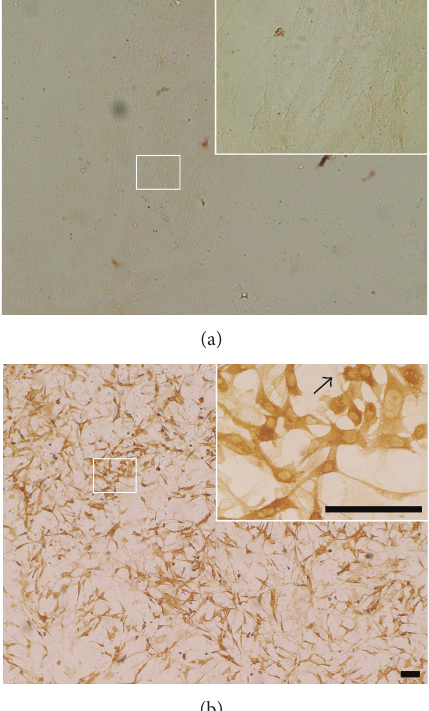
Figure 1: Immunohistochemistry of fibroblasts transfected with rAAV2-hGAD65.(a)Itdemonstratesthecontrolcellsinfectedbythe empty vector. (b) The hGAD65-positive cells were in a brown color in the cytoplasm. Fibroblasts, untransfected by rAAV2-hGAD65, were only shown in their shape (pointed by arrow). The cytoplasm expresses hGAD65, as indicated in the right upper figure. Bar = 100 𝜇 m.